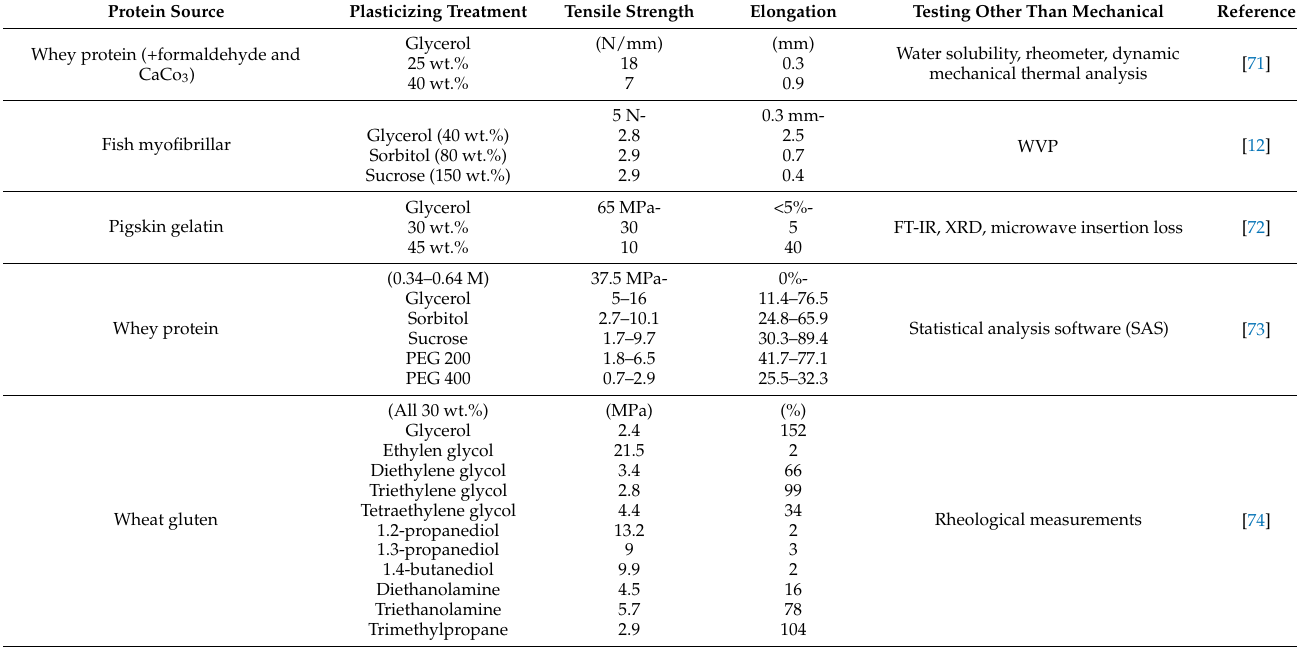
Table A2. Summary of mechanical properties of protein-based films after plasticization modification. Extended data, including error intervals and a more detailed description of methods, are provided in the respective